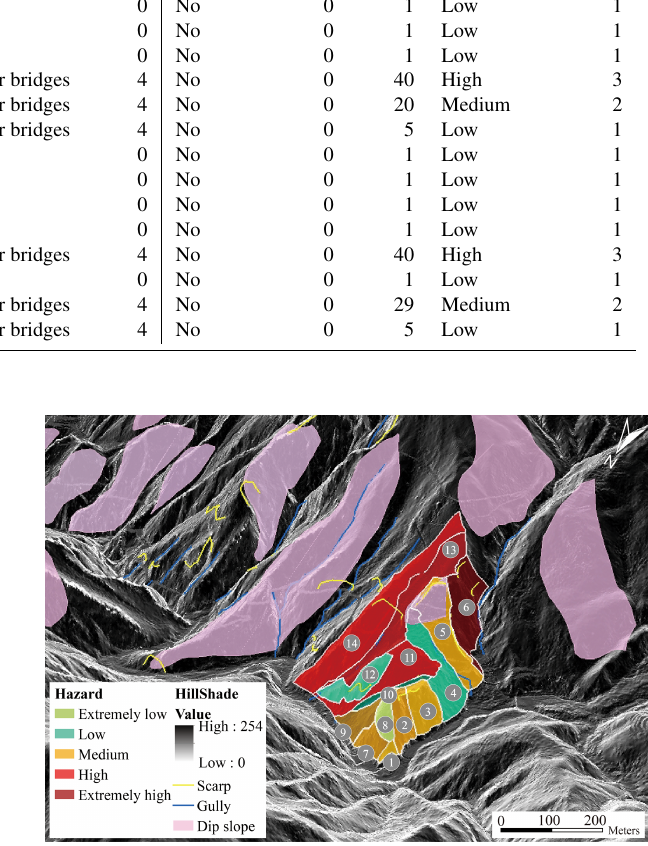
Figure 9. Hazard level mapping of landslide referring to slope units around the Neikuihui tribe (background: modified from 2020 data from the Department of Lands, Ministry of the Interior, for research purposes only; aerial: ESRI ArcGIS